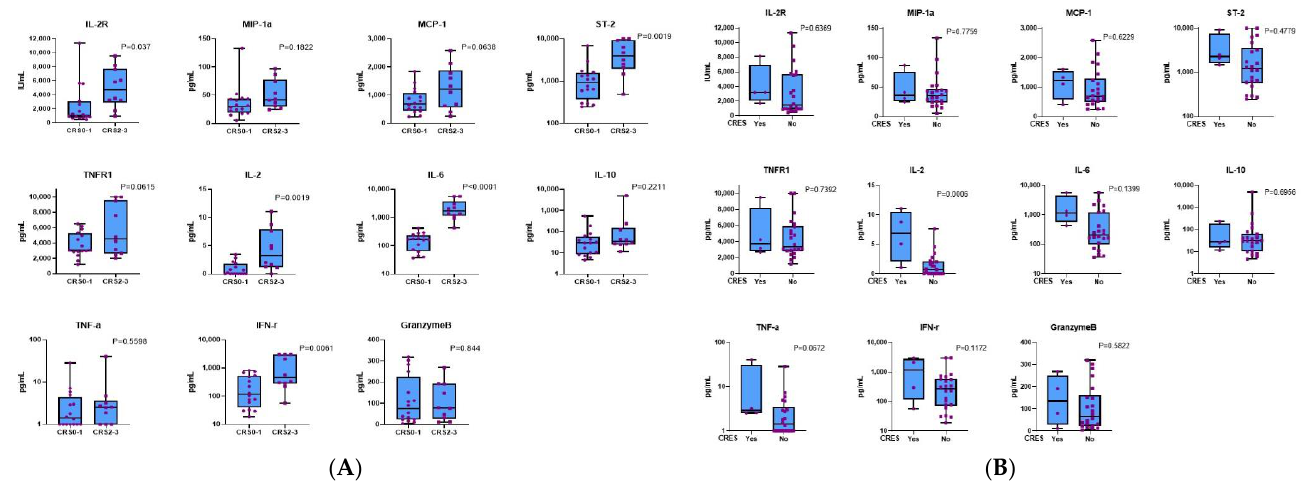
Figure 7. Peak values of cytokines in subgroups of patients. ( A ) Patients with grade 2 – 3 CRS had significantly higher peak levels of cytokines, including IL-6, IL-2, IL-2R, ST-2, and IFN- γ, than those with grade 1 CRS or without CRS. ( B ) The levels of the majority of cytokines had no significant association with ICANS grade, except IL-2. CRS: cytokine release syndrome; ICANS: immune effector cell-associated neurotoxicity syndrome.